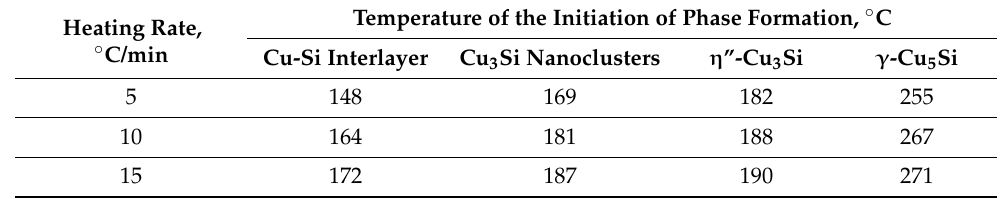
Table 2. Characteristic temperatures of the initiation of the phase formation (corresponding to the conversion rate α ≈ 0.05) in the Cu/a-Si bilayer film according to the electron diffraction data. Temperature of the Initiation of Phase Formation, ◦ C Heating Rate, ◦ C/min Cu-Si Interlayer Cu 3 Si Nanoclusters η ”-Cu 3 Si γ -Cu 5